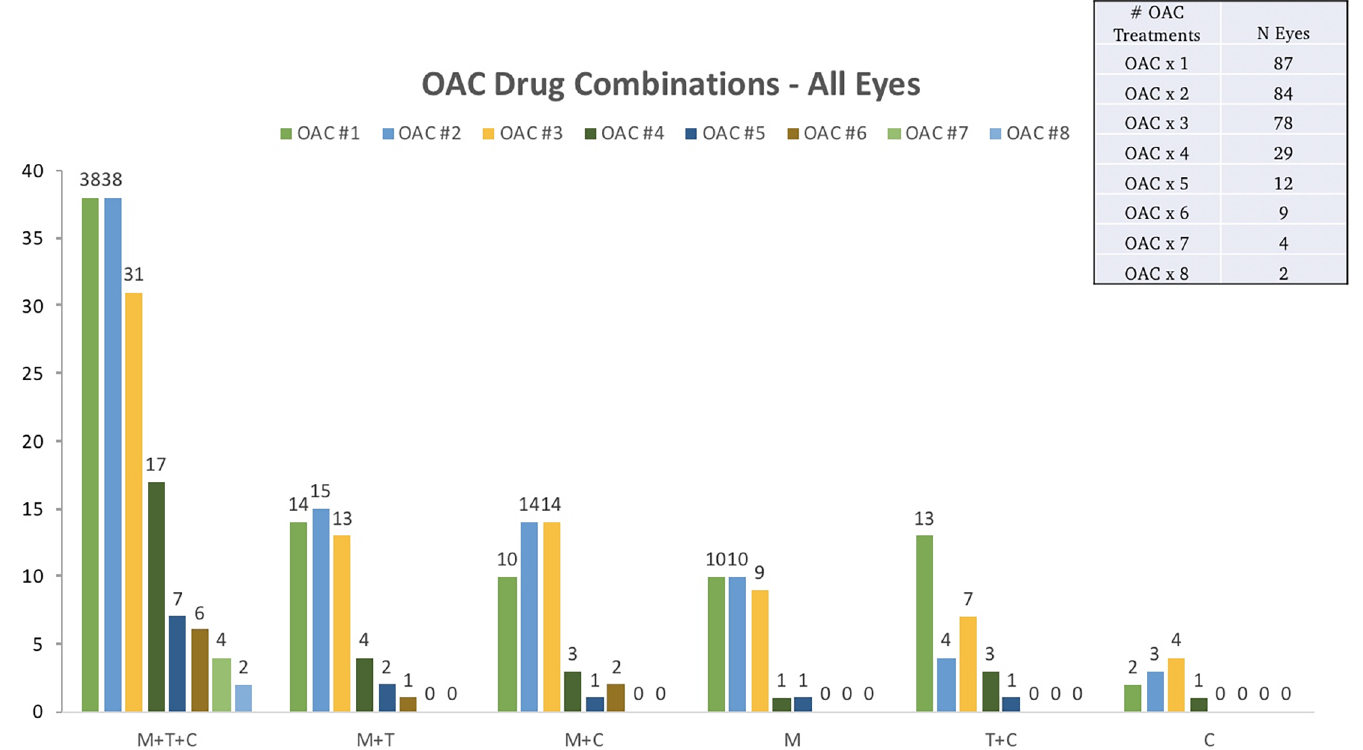
Fig 1. Frequency of drug treatment combinations per eye by OAC treatment. A combination of Melphalan, Topotecan, and Carboplatin was most commonly used across all OAC treatments. M: Melphalan, T: Topotecan, C: Carboplatin.